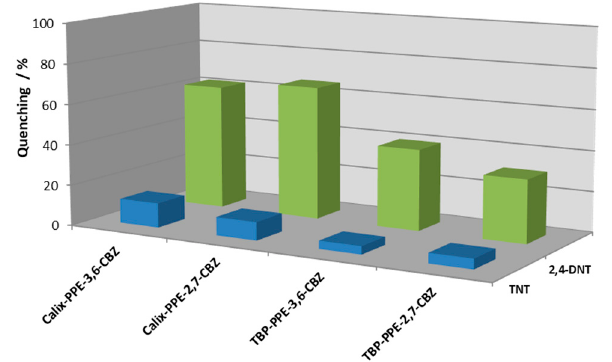
Figure 5. Fluorescence quenching responses of Calix ‐ PPE ‐ CBZs (20 nm thickness) and TBP ‐ PPE ‐ CBZs (15–50 nm thickness films; see text) upon exposure to saturated vapours of TNT and 2,4 ‐ DNT vapours (30 s) at 25 °C ( λ exc = 360 nm).